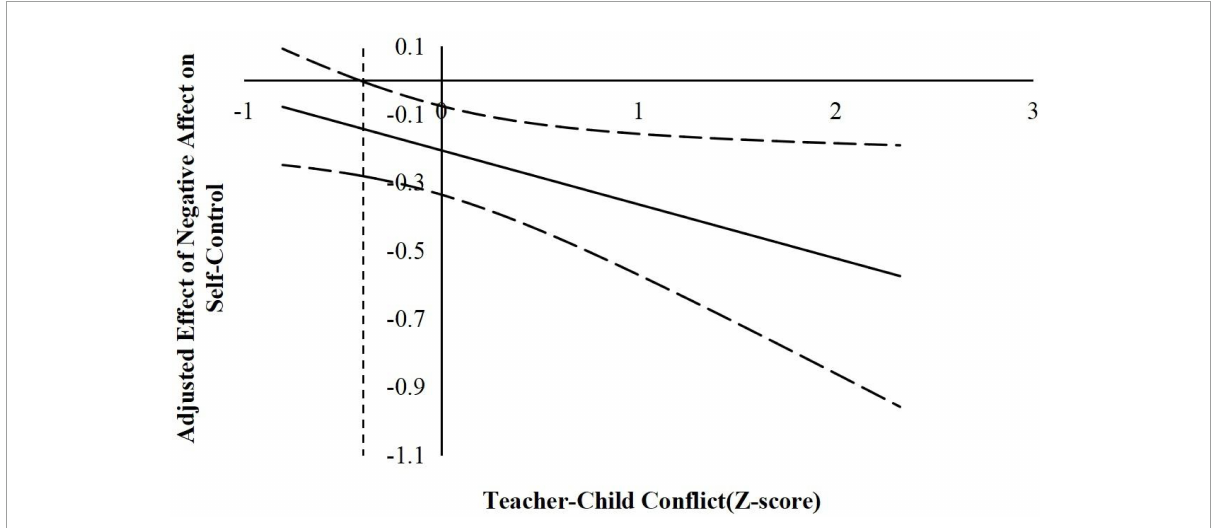
FIGURE4 The moderating effect of teacher-child conflict in the prediction of children’s negative affect on self-control. The dashed vertical line indicates the point along the teacher-child conflict in which the negative affect regression coefficient transitions from significance (right of the dashed vertical line) to non-statistical significance (left of the dashed vertical line). The value of the dashed vertical line was 0.42.